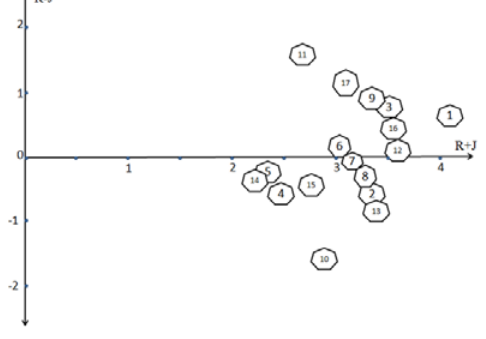
Fig. 1. Position of elements